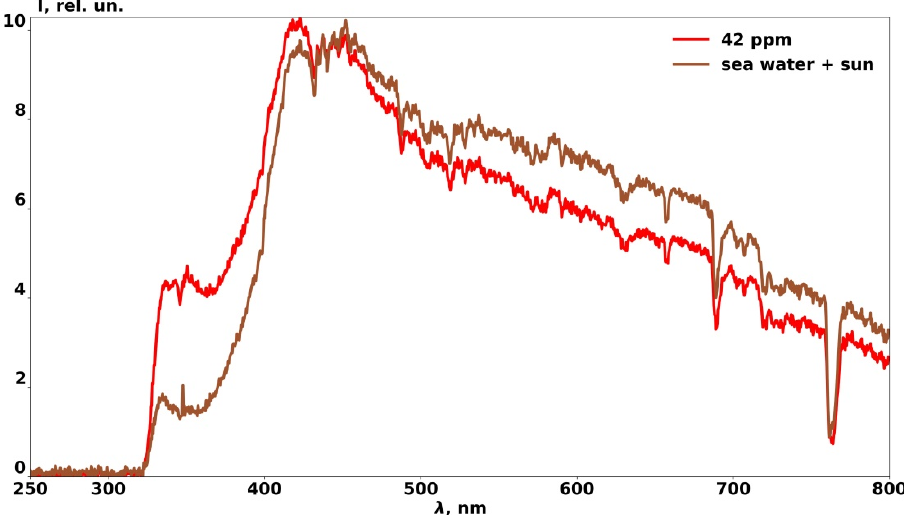
Figure 11. LIF spectrum of the DMA with a daylight background by LIDAR sounding.